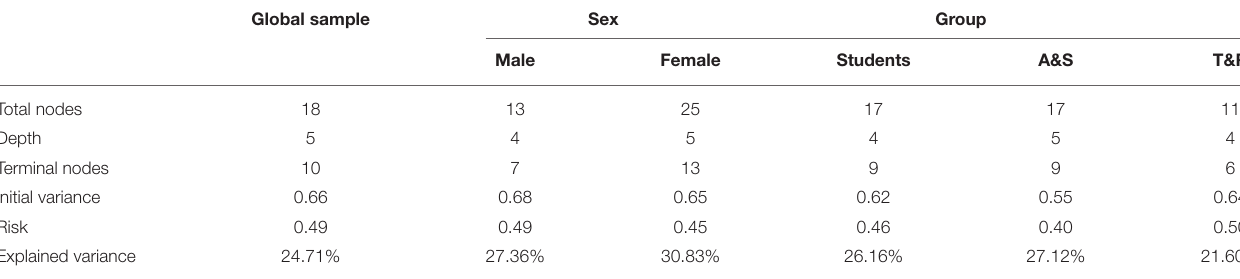
TABLE 2 | Description of the trees for positive affective states